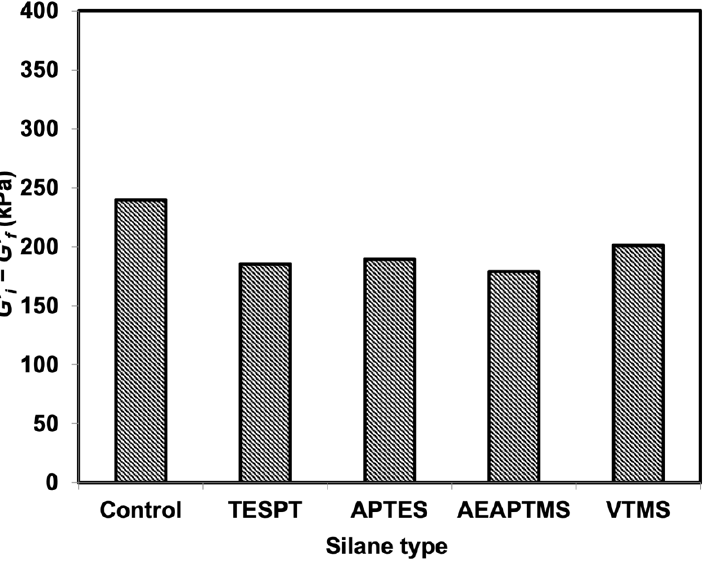
Figure 5. Payne effect of NR/HNT composites filled with and without silane coupling agents.